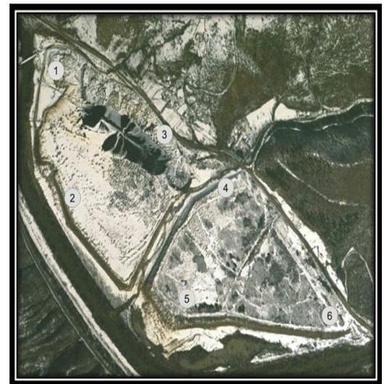
Sampling location on the Gornje Polje tailing waste deposit.